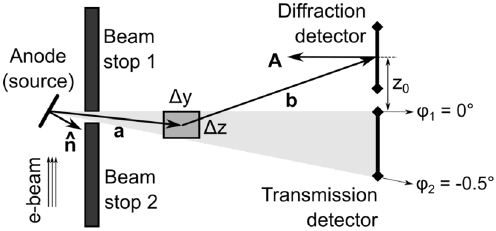
source-to-voxel vector , = n , whereas the detector pixel ˆ